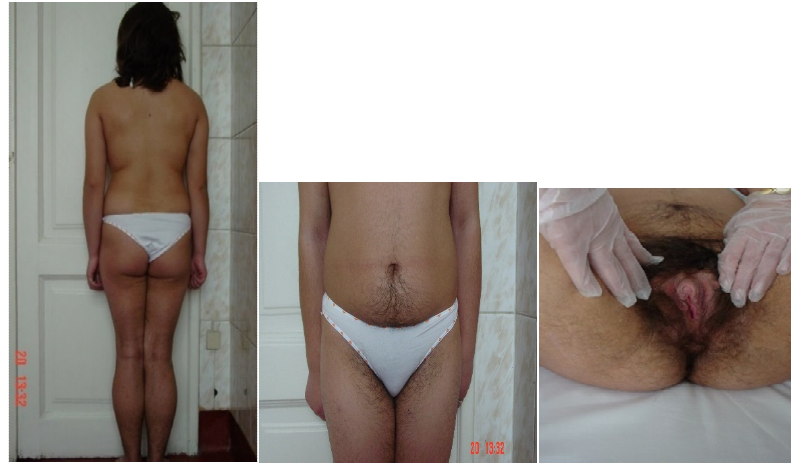
Figure 9. 46,XX DSD patient with simple virilizing form of 21-hydroxylase deficiency (Prader 2). Written informed consent was obtained from the parents for publication of these photos.